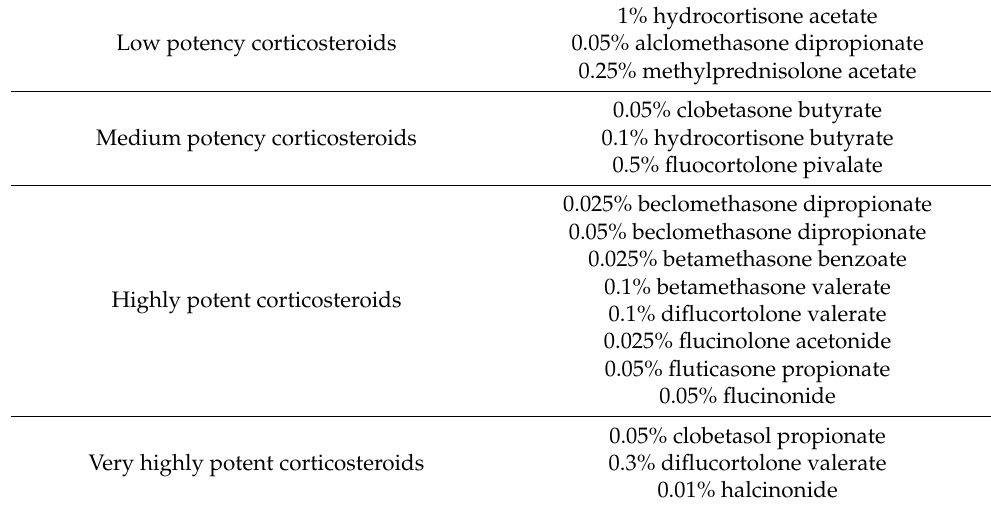
Table 2. Topical steroid preparations according to potency.